Question: Provide a one-line summary of what is displayed.
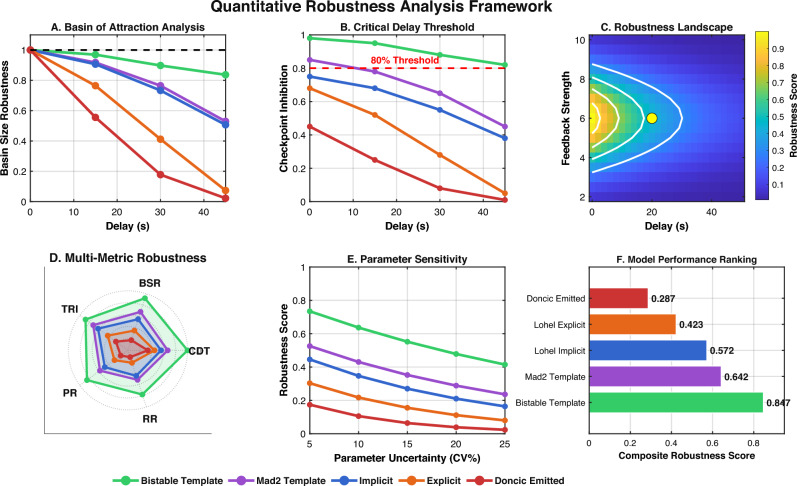
Answer: Comprehensive robustness comparison of SAC architectures. Composite robustness scores integrate checkpoint decay time, basin-size robustness, threshold-response index, parameter robustness, and resilience ratio. Higher scores indicate greater robustness to delays and perturbations.